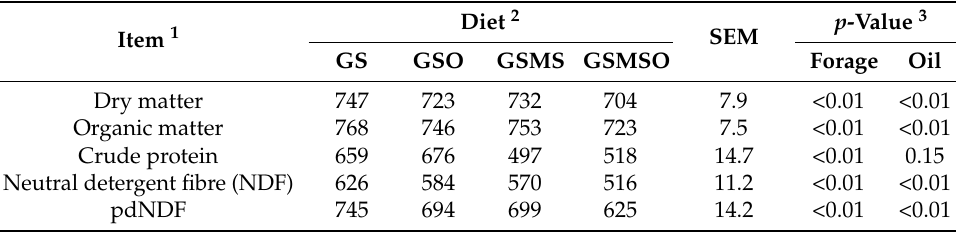
Table 4. Digestibility of dietary chemical components in cows in the experiment (g/kg; n =